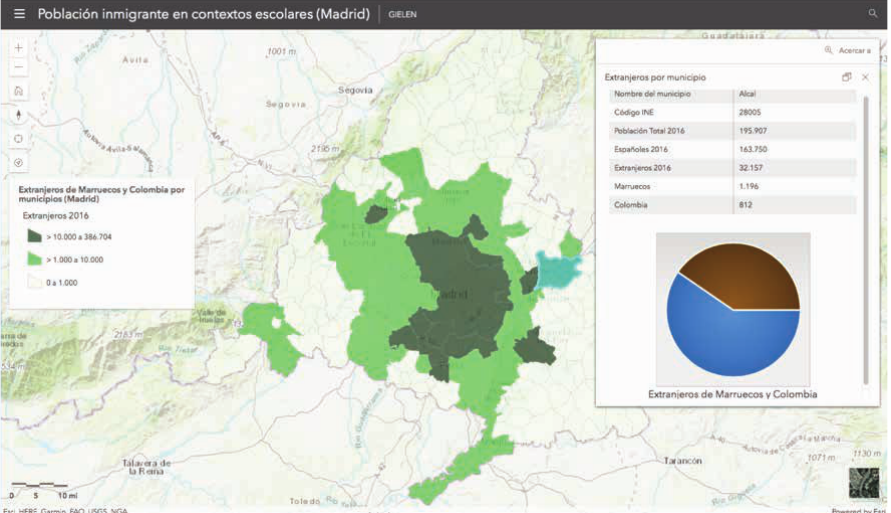
Figure 7: Sample of sociodemographic study performed using the Web Mapping Application “Immigrant population in educa- tional